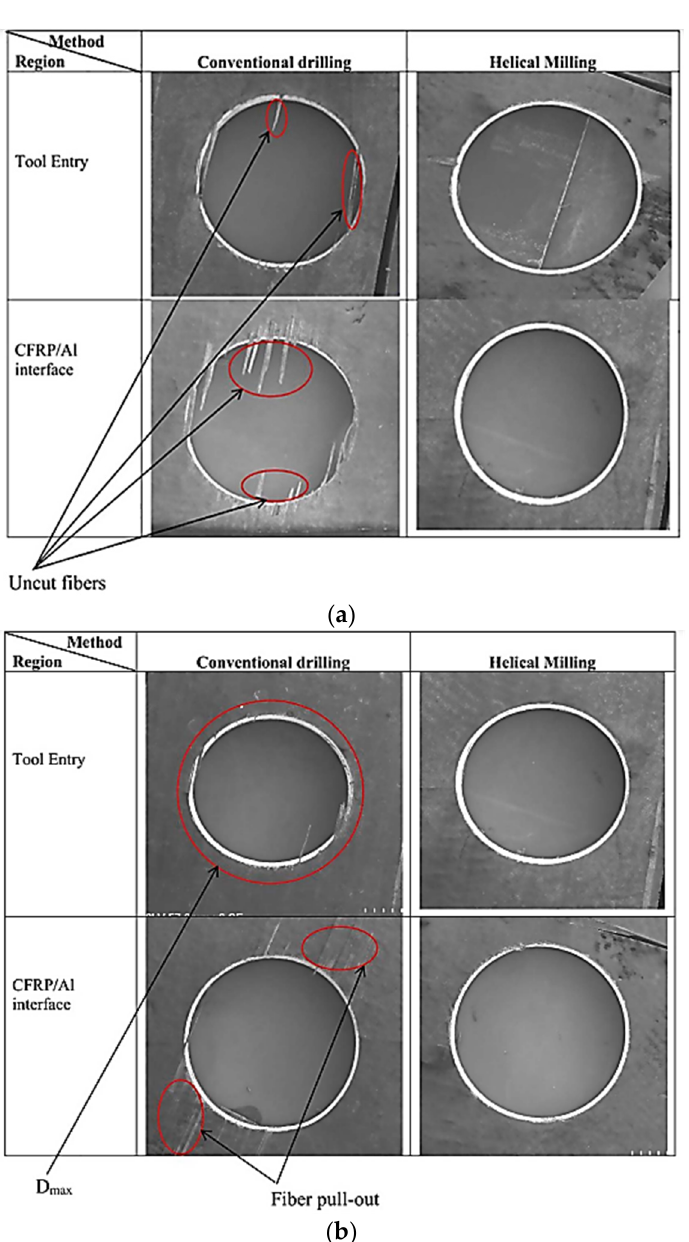
Figure 9. Scanning Electron Microscope (SEM) images comparing hole quality of both conventional and helical milling methods (steps 1 ( a ) and 2 ( b )) [85].